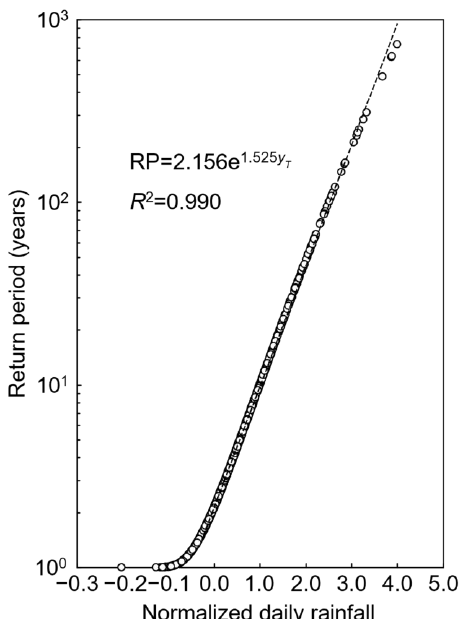
Figure 6. Quantile – quantile plot. Figure 6. Quantile–quantile plot.